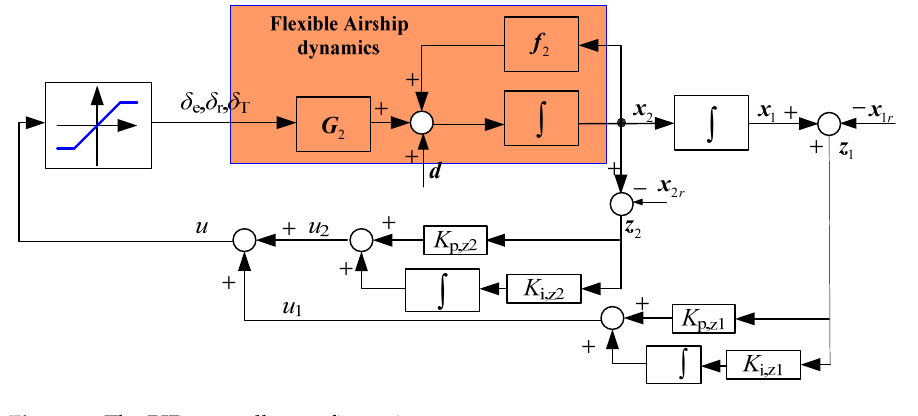
Figure 3. The PID controller configuration. The controller parameters are designed as shown in Table 2. Table 2. Selected parameters of the controller.